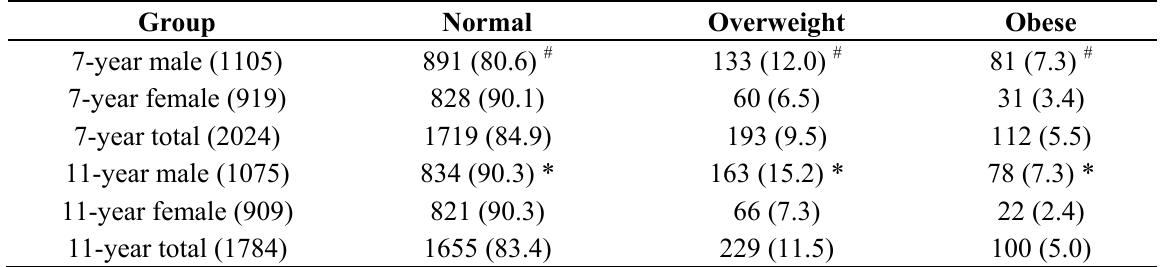
Table 1. Prevalence rates of being overweight and obesity in 7- and 11-year old Chinese children of Yueyang city.